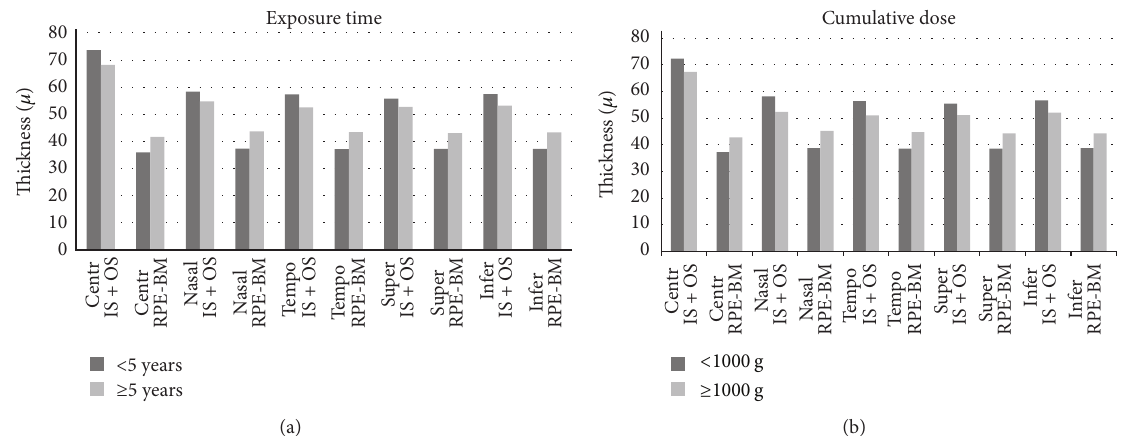
Figure 2: Bar graphs represent the photoreceptor total segment (IS + OS) thicknesses and retinal pigment epithelium- (RPE-) Bruch’s membrane complex thicknesses; each one is noted according to the levels of the hydroxychloroquine exposure time values. These values are found to be statistically